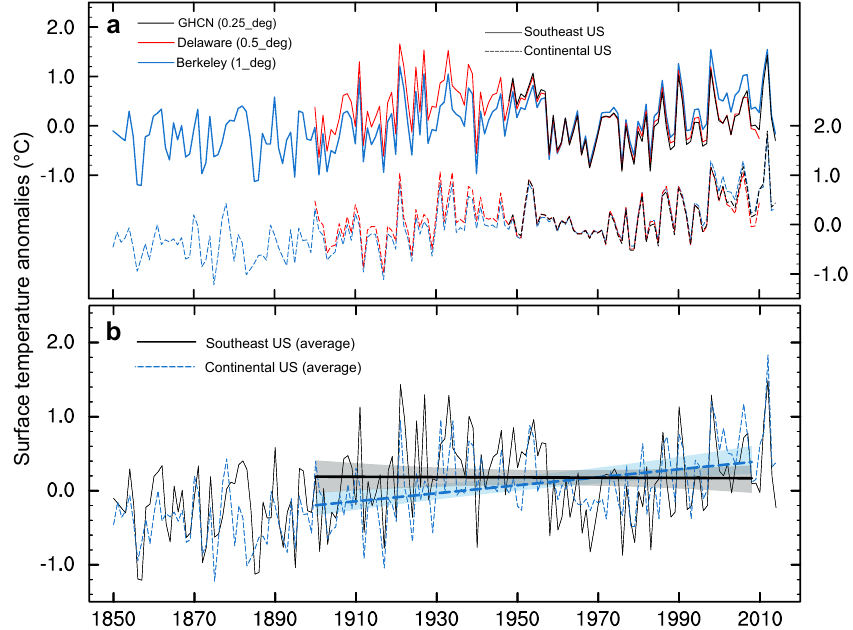
Figure 1. Time series of mean annual temperature anomalies for the southeast US (solid lines; 30–35 ◦ N, 95–80 ◦ W) and the continental US (dashed lines; 25–50 ◦ N, 125–65 ◦ W). For panel ( a ), the unique colors represent three independent gridded temperature datasets–red = Delaware, black = GHCN and blue = Berkeley; For panel ( b ), the lines are each respective region’s mean temperature anomaly, averaged across all three datasets in ( a ). The trend lines in ( b ) are linear trends of temperature anomalies from 1900–2008, with error estimates, calculated using bootstrapping techniques ( n = 1000), shown as the solid shaded